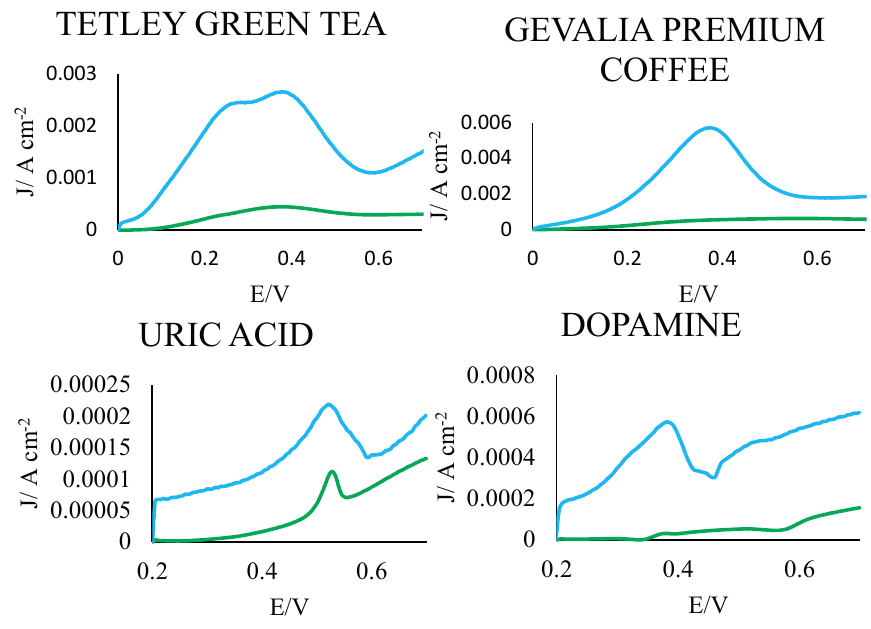
Figure 4. Proof of principle. Representative voltammograms of the PGEs (blue) and GCEs (green) in samples of coffee, tea, UA (0.00001 M) and DA (0.00001 M). To account for differences in exposed area, current is given as a function of raw current divided by electrode surface area.